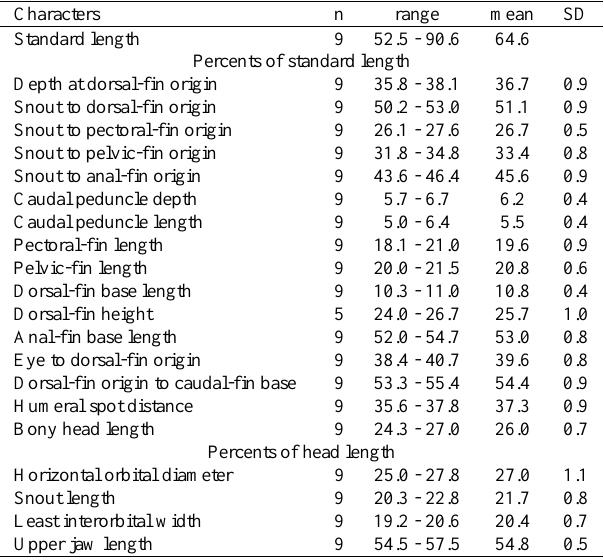
Table 2. Morphometrics of Charax caudimaculatus . Specimens are from USNM